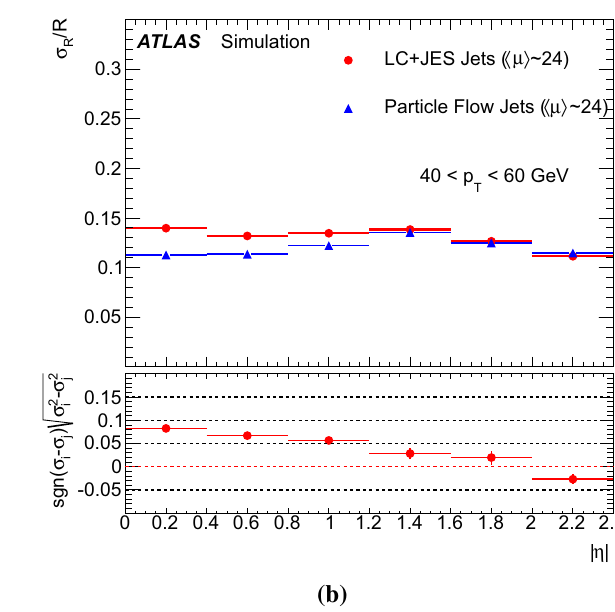
Simulated pile-up conditions are similar to the data-taking in 2012. To quantifythedifferenceinresolutionbetweenparticleflowandcalorime- ter jets, the lower figure shows the square root of the difference of the squares of the resolution for the two classes of